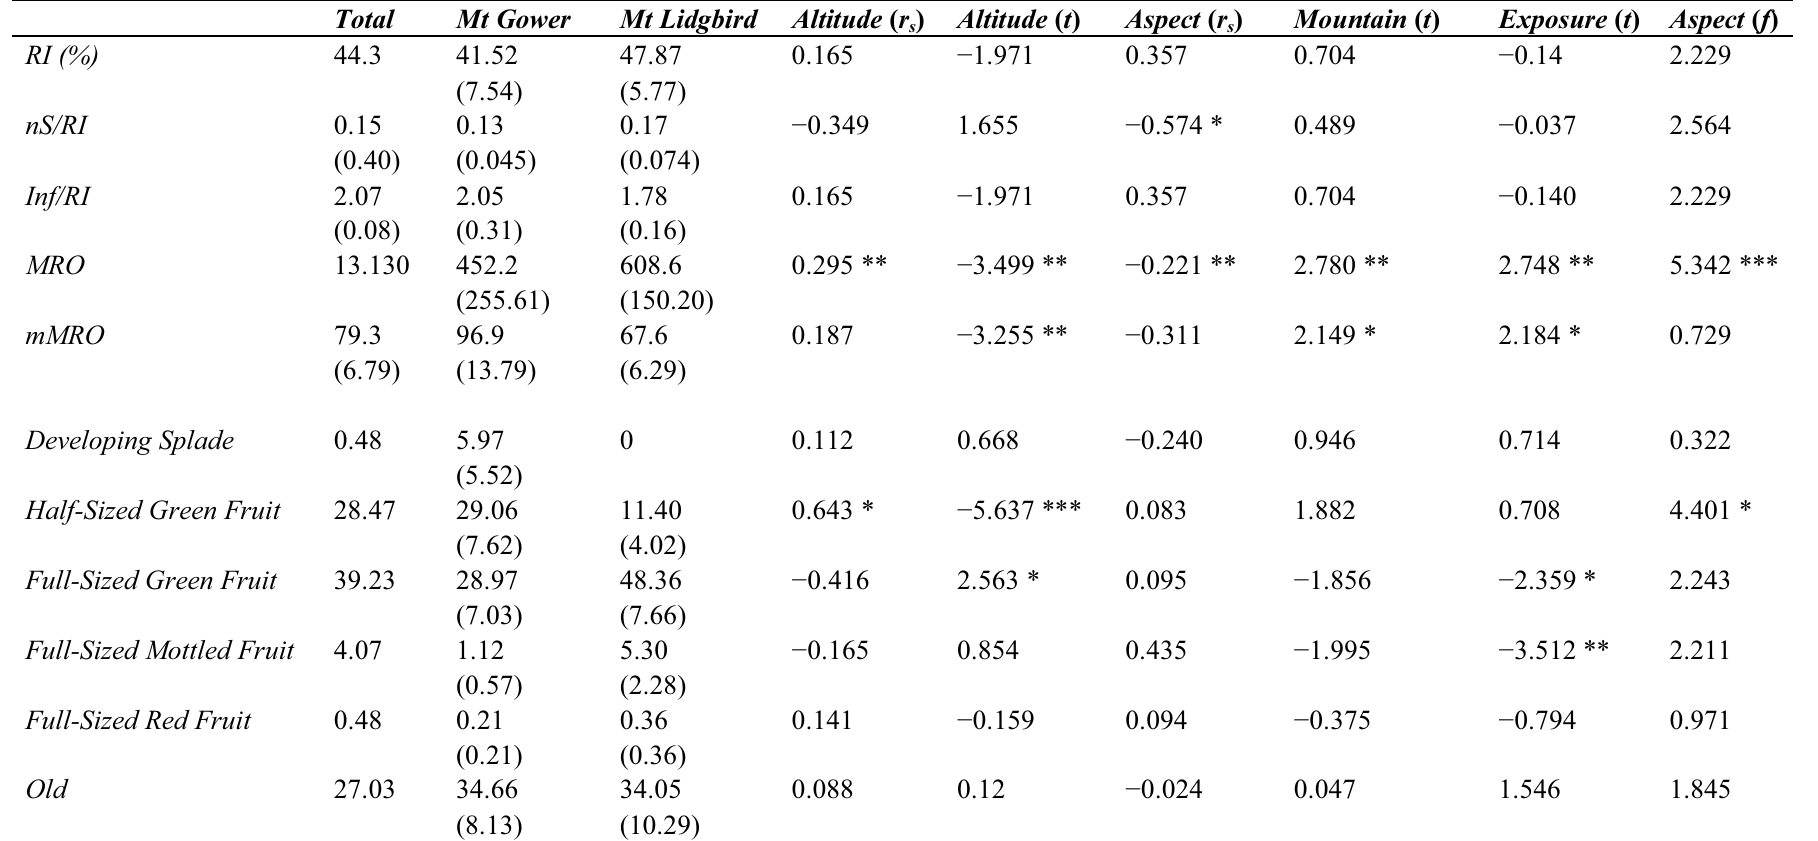
Table 3. Summary of reproductive measures of H. canterbuyana RI (%), the proportion of population at reproductive age with reproductive activity; Mean nS/RI the mean number of seedlings per actively reproductive individual; Inf /RI inflourescence per reproductive individual; MRO , maximum reproductive output, the sum of all fruit abundance; Mean MRO , average maximum reproductive output per reproductive individual; mMRO , mean maximum reproductive output of mature sized fruits; iMRO , mean maximum reproductive output of immature sized fruits. Standard errors in parenthesis. Results of Spearman (cid:182) s rank correlation for altitude and aspect ( r the effects of mountain, mountain shade and high and low altitudes; ANOVA ( f ) between populations at different cardinal aspects. * p < 0.05, ** p < 0.01, *** p <